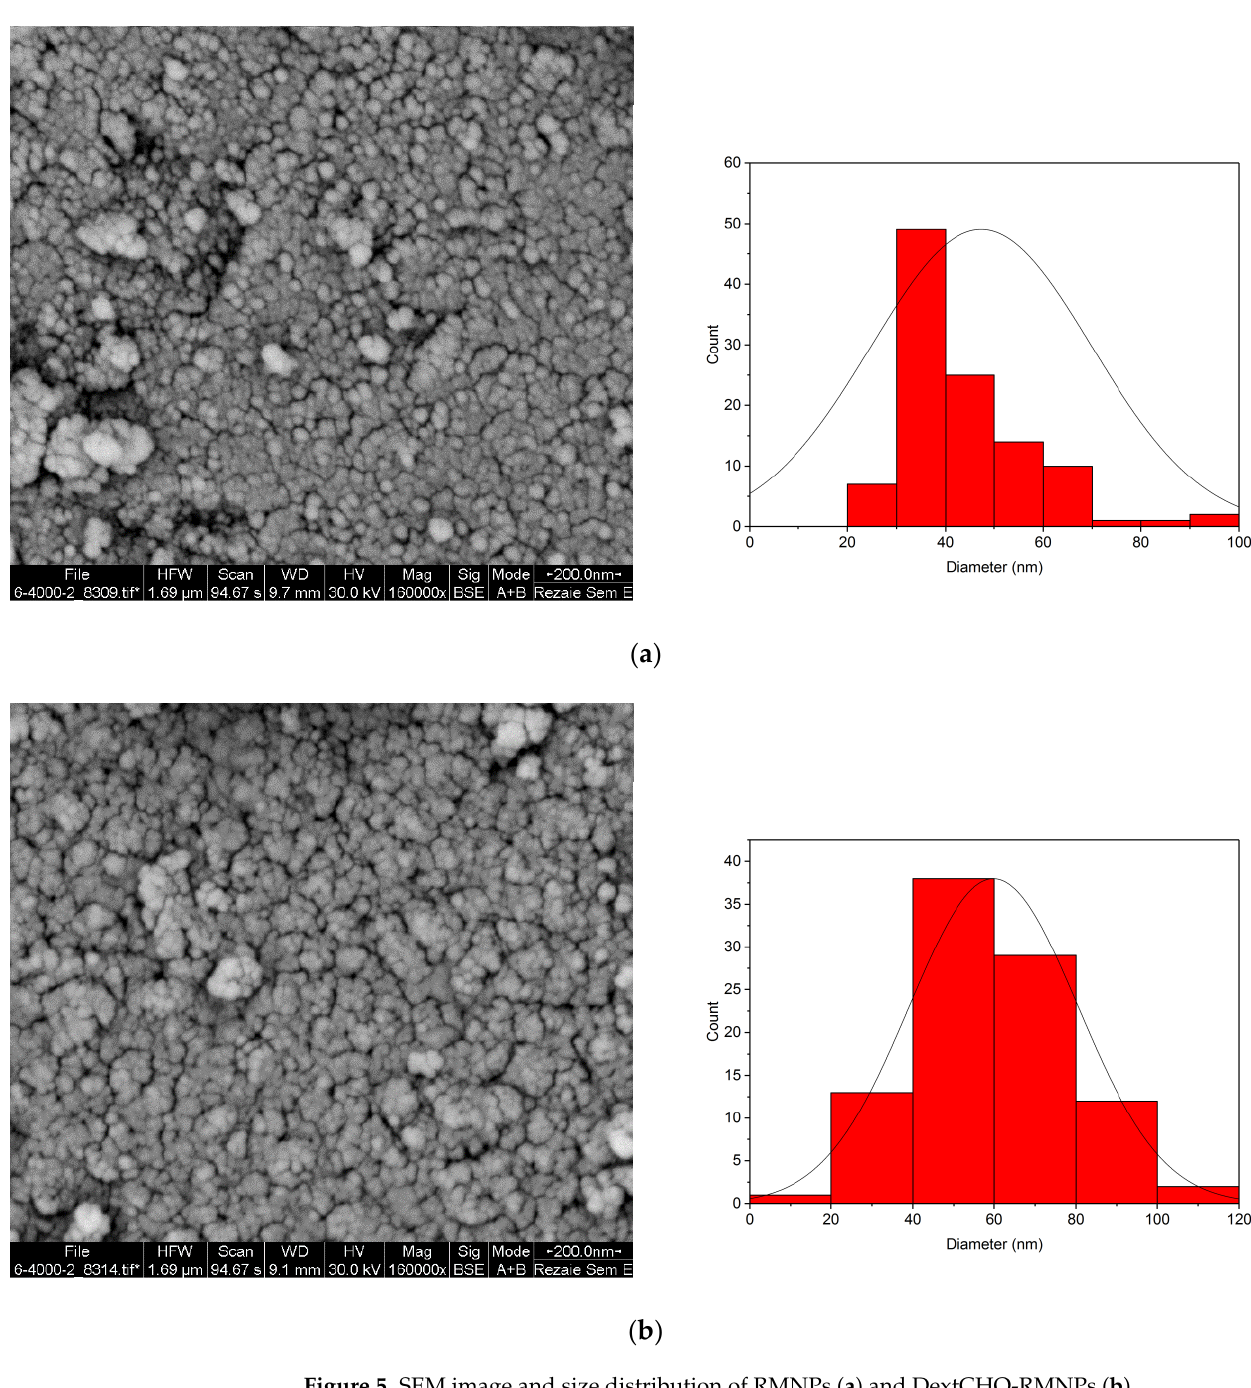
Figure 5. SEM image and size distribution of RMNPs ( a ) and DextCHO-RMNPs ( b ).